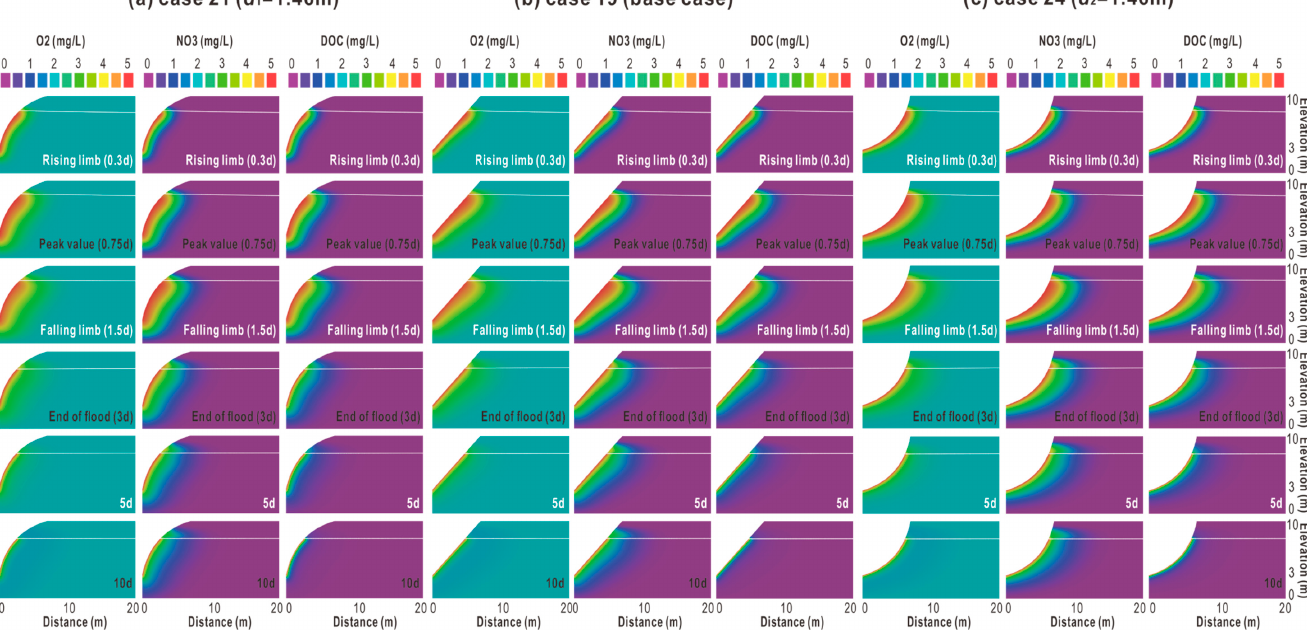
Figure 5. The effect of different bank forms on riparian nitrogen cycle driven by water level fluctuation. The white lines represent groundwater levels. d 1 and d 2 denote the convex and concave distance, respectively.